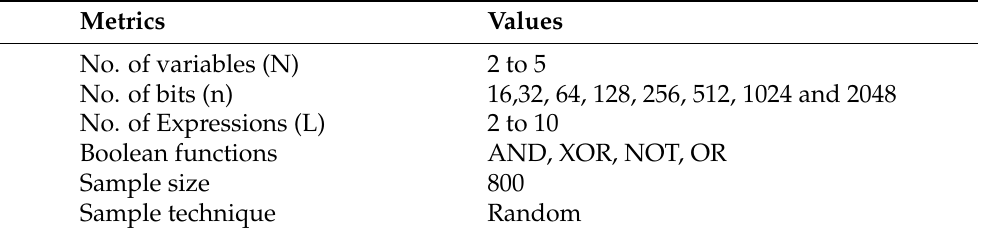
Table 1. Metric set-up.